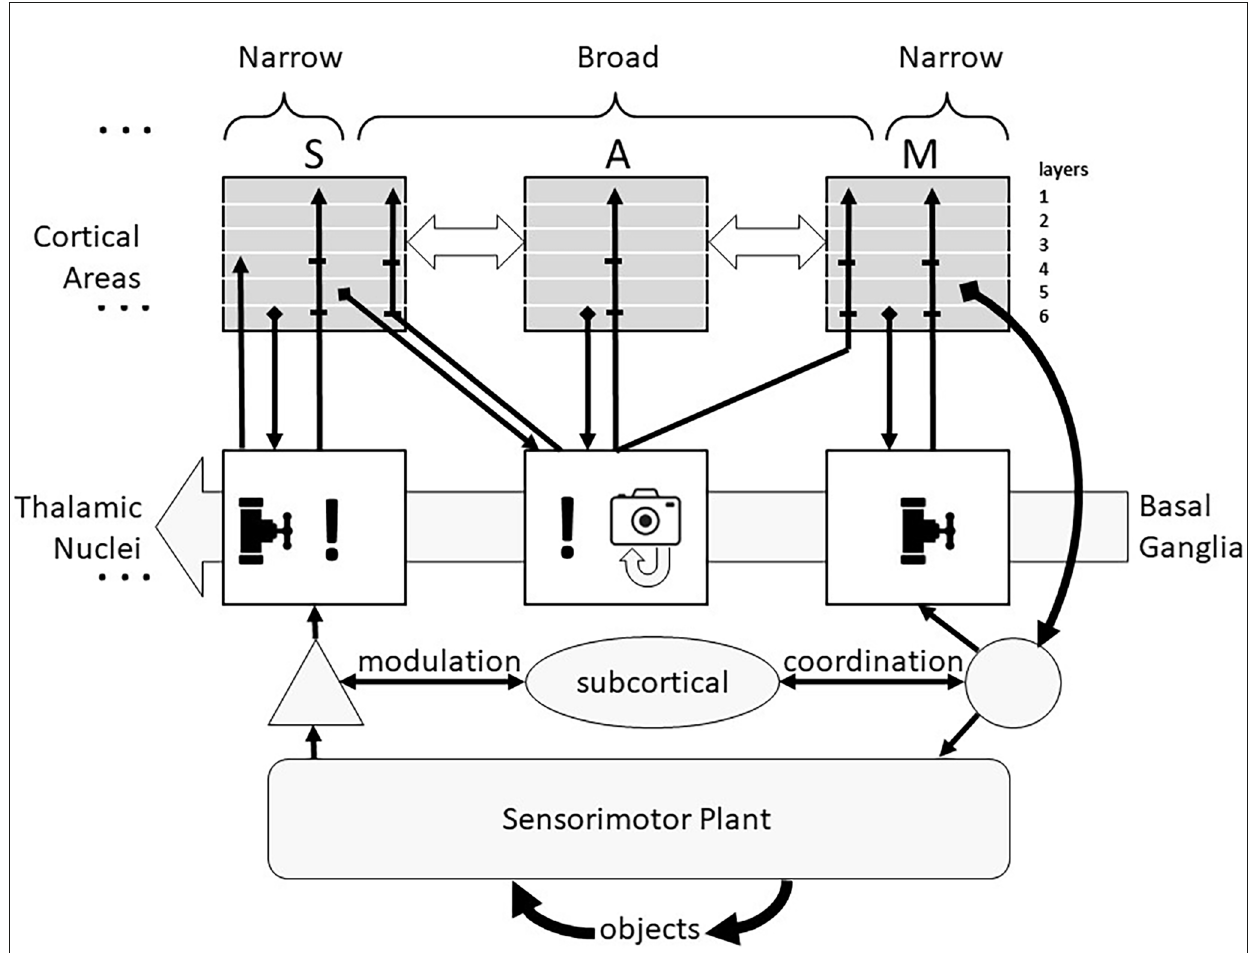
FIGURE1 Corticothalamic recurrent circuits support similar computational functions in all cortical areas. The transmission of sensory information from all receptor modalities (except olfactory) to cortex is modulated in thalamus (valve symbol) and the excitability of the multiple primary sensory (S) cortical areas to that information is modulated by Narrow thalamocortical projections (!). If the sensory information is incongruent with any of the familiar expectations, corticothalamic activity leads to activation of Broad thalamocortical projections from non-sensory thalamic neurons that recruit cognitive processing by other sensory, associative (A) and motor (M) cortical areas, often culminating in the identification of an exploratory action to obtain additional sensory information about the unknown object. The thresholds for these thalamic recruitments of cortical functions (including overt exploratory actions) are set by the Basal Ganglia in consideration of a risk-benefit analysis. The Broad thalamocortical projections are also capable of Hebbian potentiation of their synapses onto currently active cortical neurons, providing a snapshot memory (camera icon) of the incongruent sensorimotor activity that can be replayed off-line by spontaneous activity in those thalamocortical neurons. The general locations of cortical inputs and outputs are shown by layers. The corticothalamic system adds sophisticated cognitive decision-making to a subcortical system (tectum, reticulospinal system, and cerebellum) that is itself capable of fast and accurate sensorimotor performance. Collateral discharge from this system passes through thalamic nuclei to motor cortical